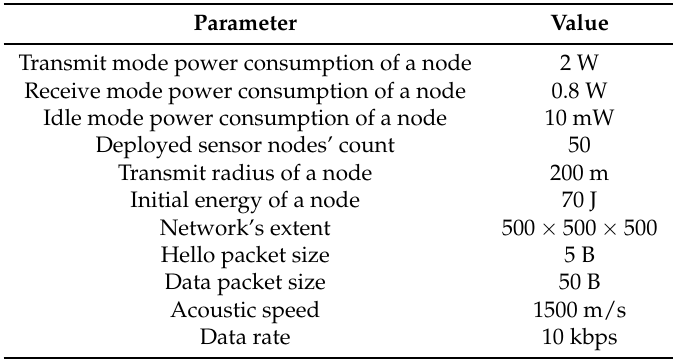
Table 1. Description of the parameters involved in the